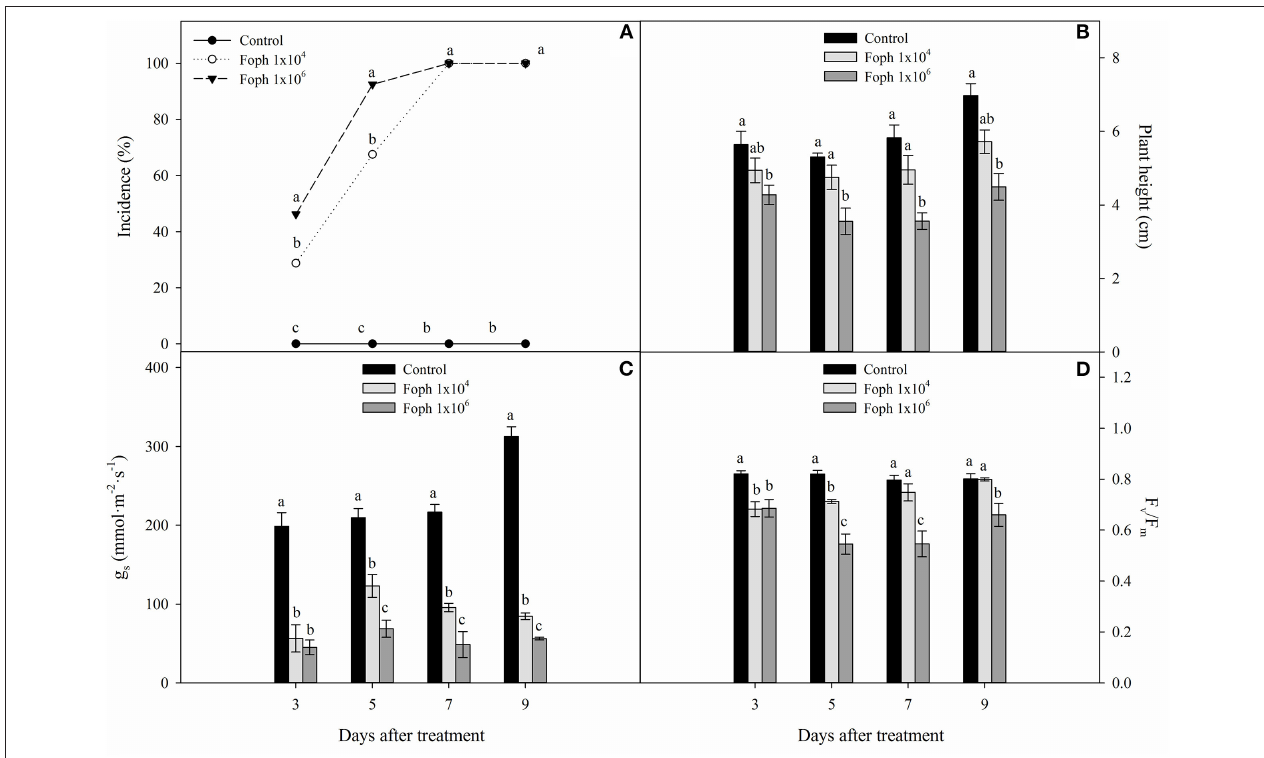
FIGURE 1 | Development of vascular wilt caused by Fusarium oxysporum f. sp. physali (Foph) in cape gooseberry plant ecotype Colombia and variables of growth and plant physiology in a hydroponic system. (A) Incidence of disease under two inoculum densities, (B) plant height, (C) stomatal conductance ( g s ), and (D) quantum yield of photosystem II (F v /F m ). Each bar or point chart represents the mean of three values ± standard error ( n = 3). Bars or points followed by different letters indicate statistically significant differences according to the Tukey test ( P ≤